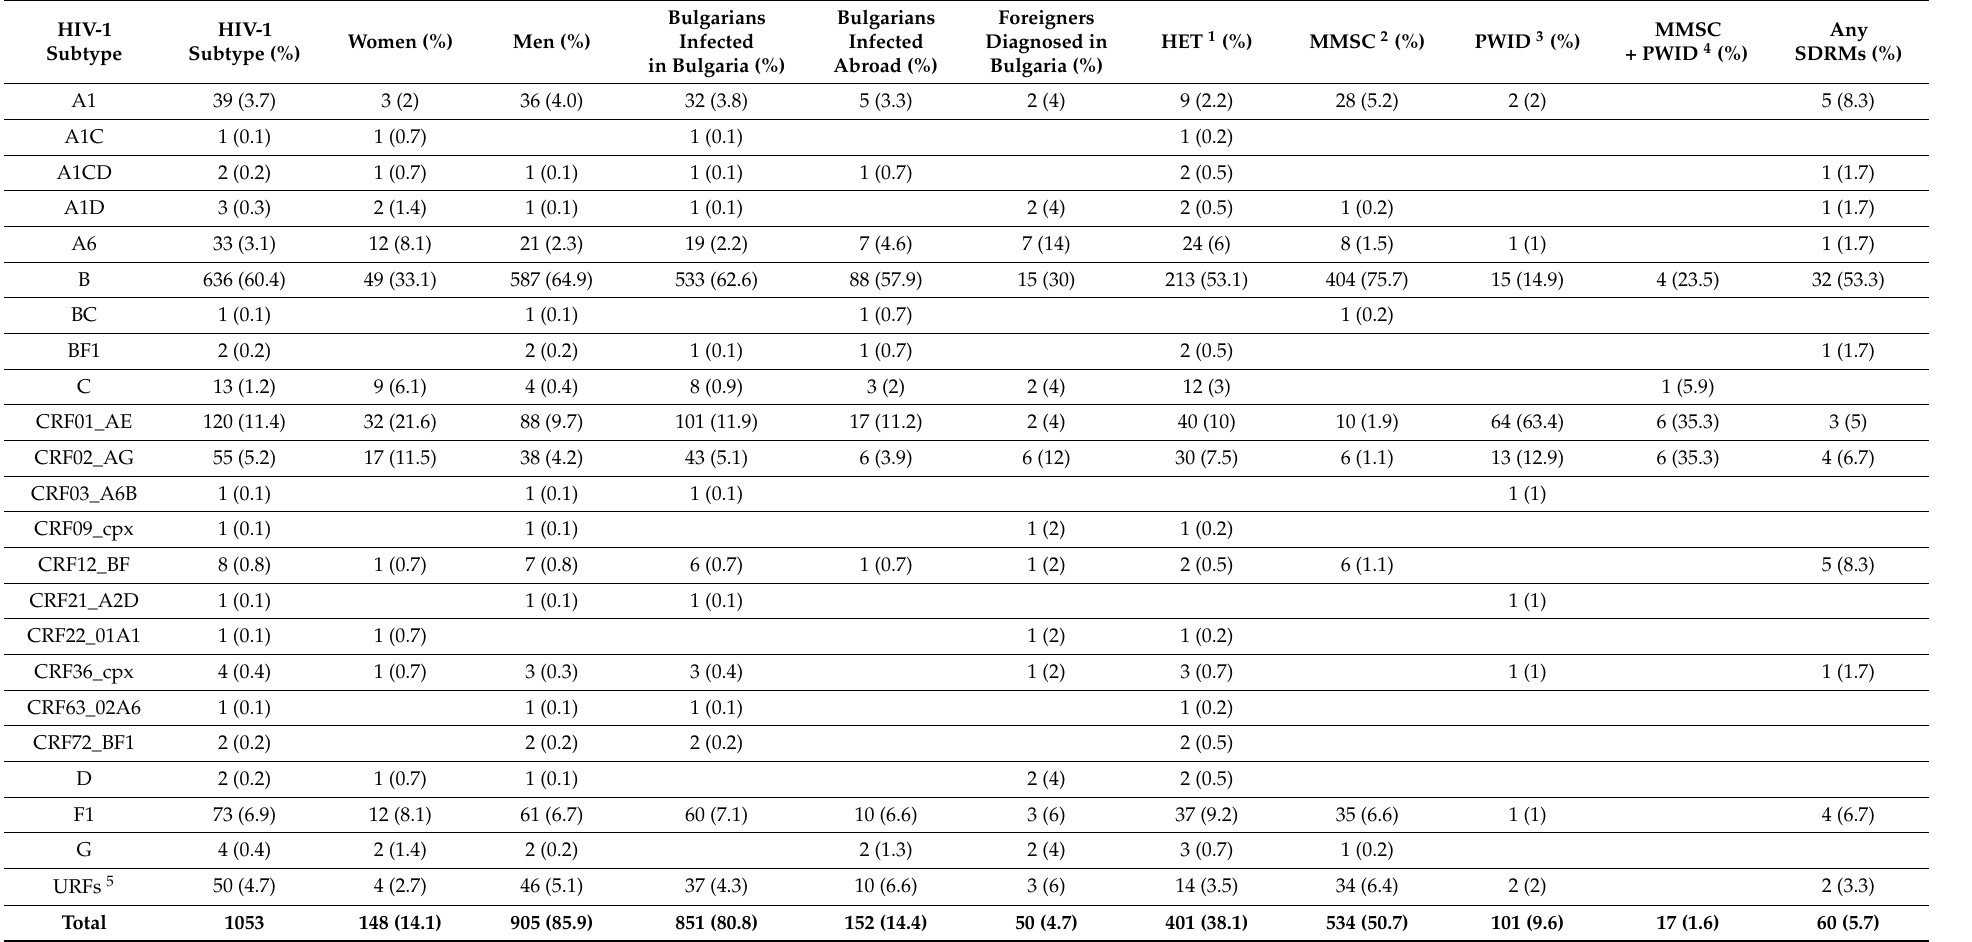
Table 2. High HIV-1 genetic diversity in antiretroviral-naive